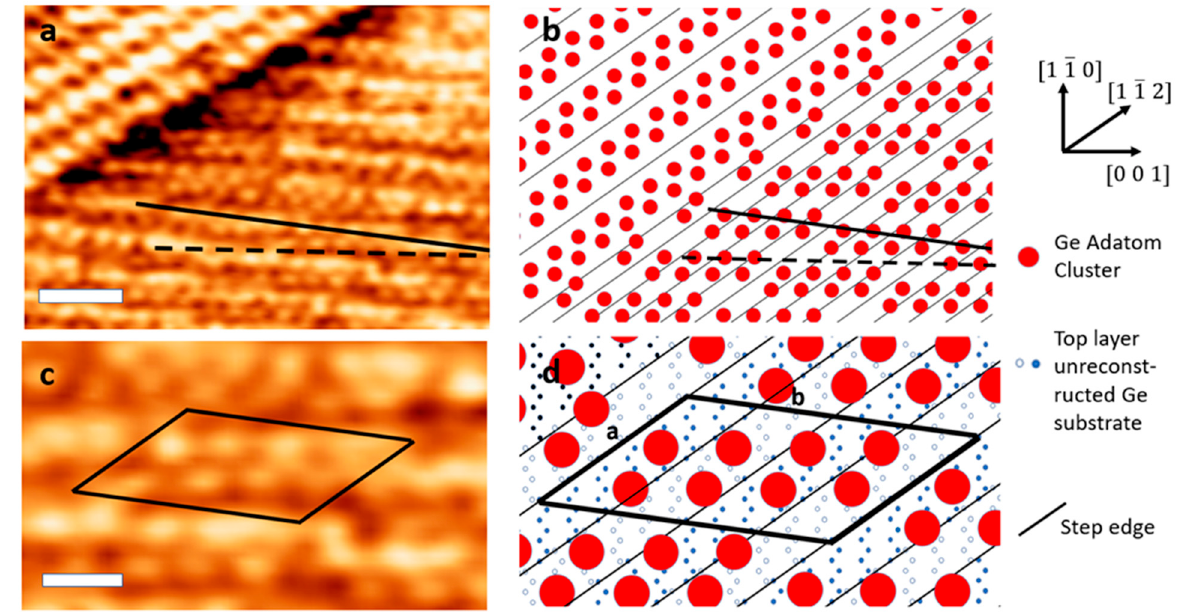
Figure 7. STM images and models of Ge (110) faceting. ( a ) STM topography of {17 15 1} faceting on the left and {19 15 1} faceting on the right. ( b ) Model of {17 15 1} faceting on the left and {19 15 1} faceting on the right. ( c ) STM image of proposed unit cell. ( d ) Model of proposed unit cell. The dotted line in ( a , b ) shows the direction of short-range order, while the solid line shows the direction of long-range order. In models ( b , d ), the height of the substrate increases by one atomic layer at each step edge moving to the right. Scale bars: ( a ) 5 nm, ( c ) 2 nm. A unit cell of a common superstructure is shown in ( c , d ), with lengths a: 34.7 Å and b: 57.7 Å (corresponding to 5 √ (3/2) a, and √ 104 a, where a = 5.66 Å).